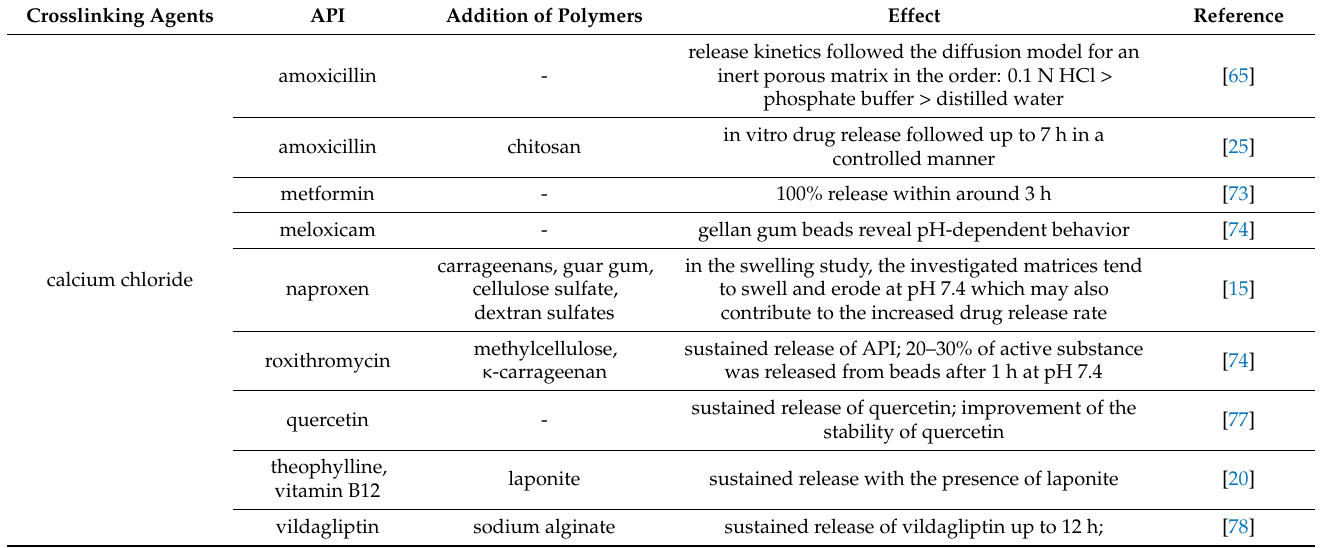
Table 1. Examples of oral microbeads prepared by ionotropic gelation. Crosslinking